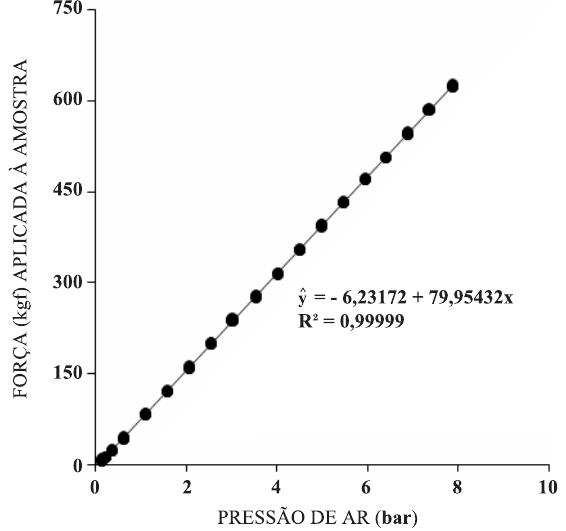
Figura 3. Curva de calibração do consolidômetro: variação da força aplicada à amostra de solo em função da pressão de ar no cilindro pneumático. N = 90 para cada pressão